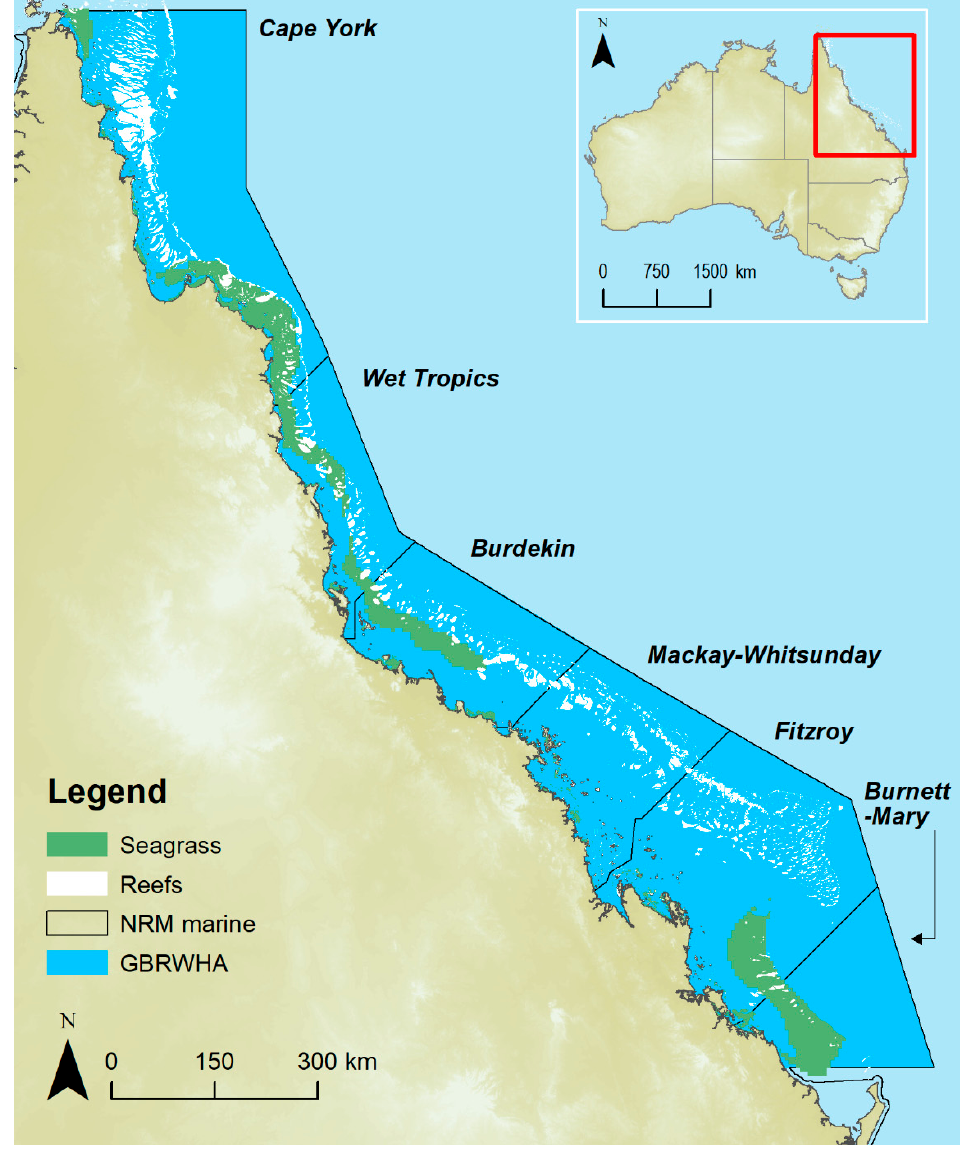
Figure 1. Seagrass meadows composite map [7,8], coral reefs [9], the Great Barrier Reef World Heritage Area, and marine portions of each Natural Resource Management (NRM) region.